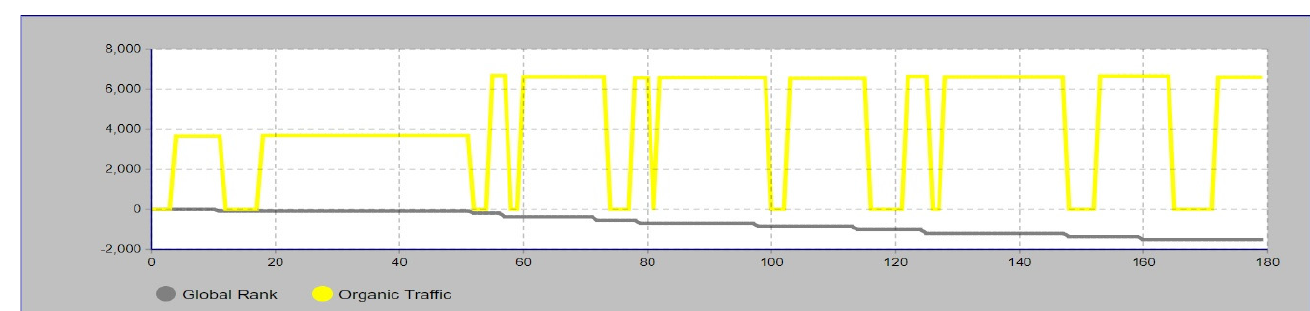
Figure 8. Organic traffic and global rank development in 180 simulation days .